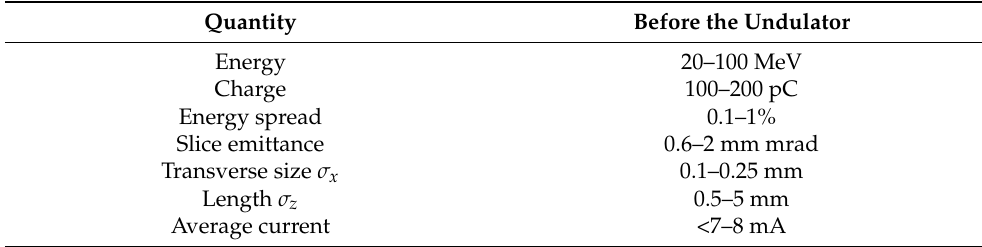
Table 1. Electron beam characteristics at the undulator entrance.